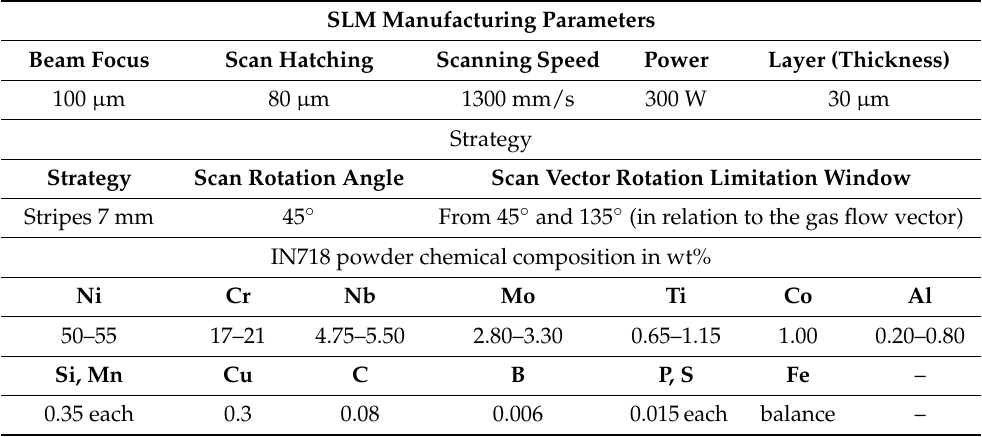
Table 1. SLM process parameters and the chemical composition of the IN718 powder. SLM Manufacturing Parameters Beam Focus Scan